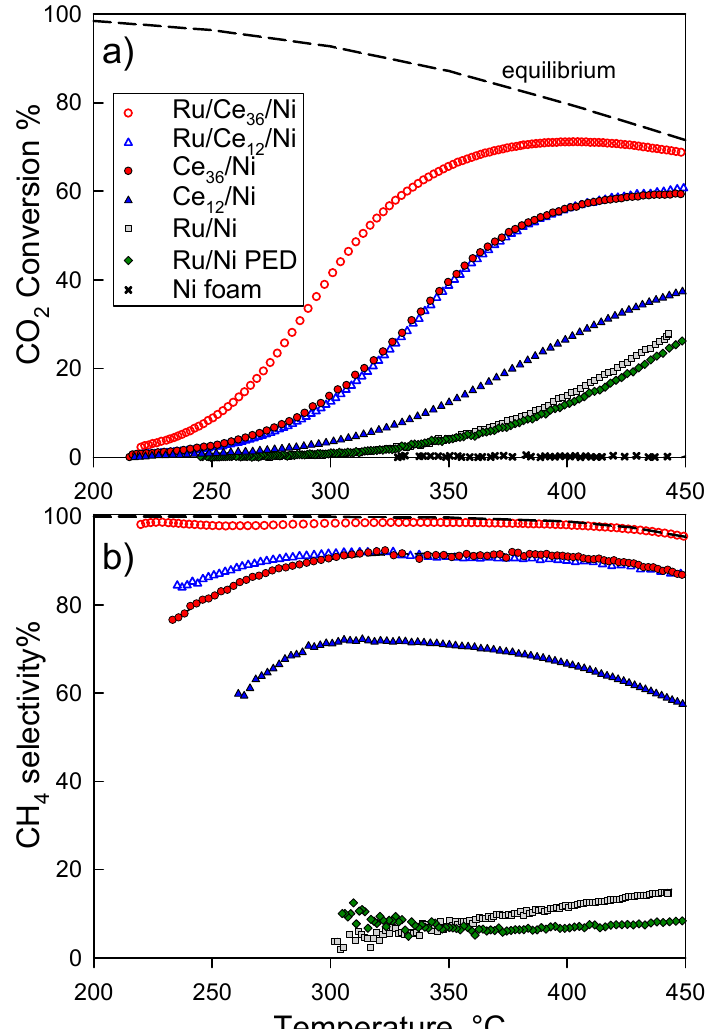
Figure 5. CO 2 conversion ( a ) and CH 4 selectivity ( b ) as a function of the reaction temperature during the hydrogenation of CO 2 over foam catalysts. Feed: CO 2 /H 2 /N 2 = 1/4/5. Dashed lines represent thermodynamic equilibrium values (at constant T and P).